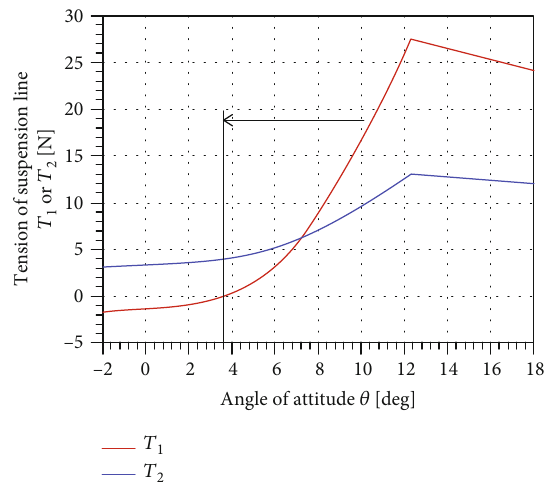
Figure 8: Tensions of suspension lines as a function of the attitude of angle.